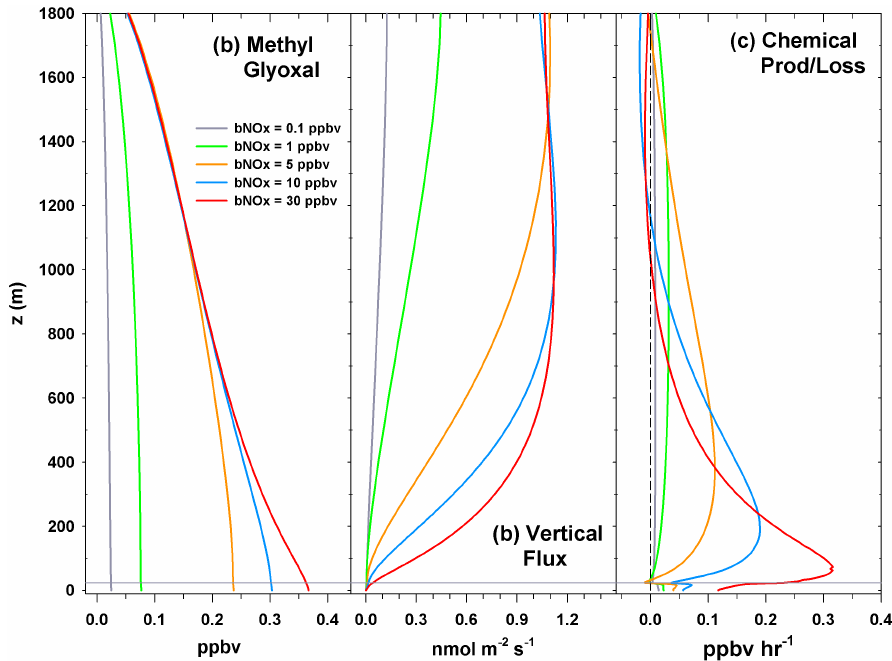
Fig. 12. Vertical profiles of methyl glyoxal (a) mixing ratio (ppbv), (b) vertical flux (nmolm − 2 s − 1 ) , and (c) chemical production or loss (ppbvh − 1 ) for each background NO x value (horizontal gray line is canopy top height).